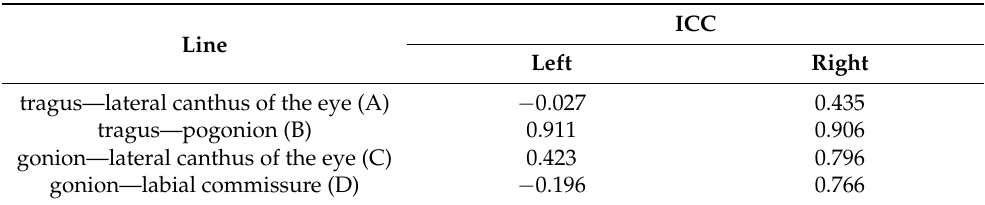
Table 2. Intraclass Correlation Coefficient (ICC) for repeated measurements of the demarcation lines (intra-rater reliability).